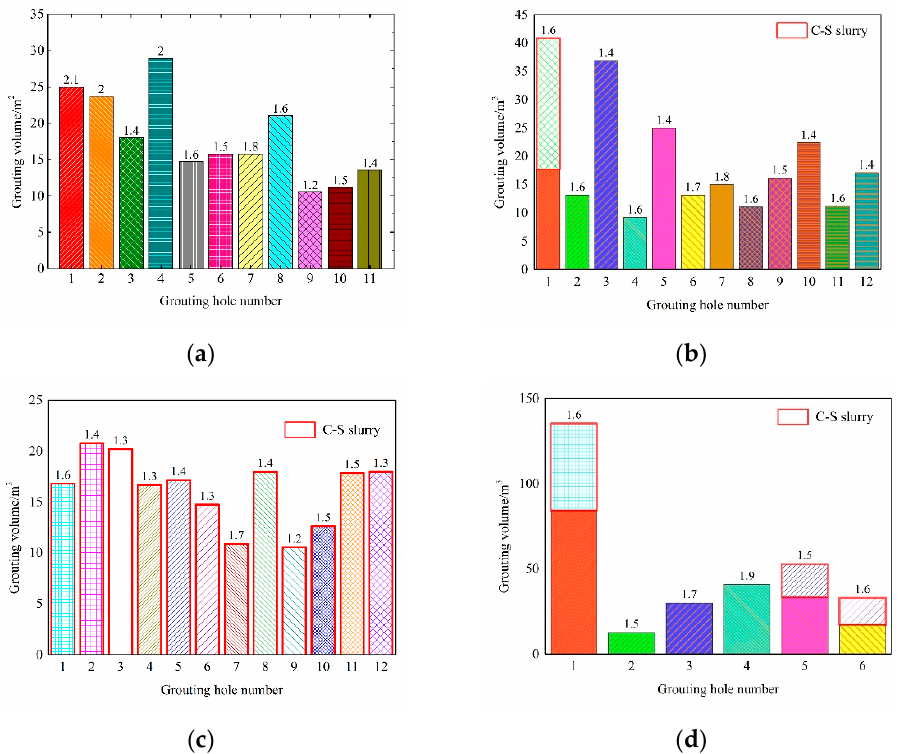
Figure 13. Grouting volume of single hole in ( a ) D3K279 + 898 ( b ) D3K279 + 905.5 ( c ) D3K279 + 925.5 and ( d ) D3K279 + 938